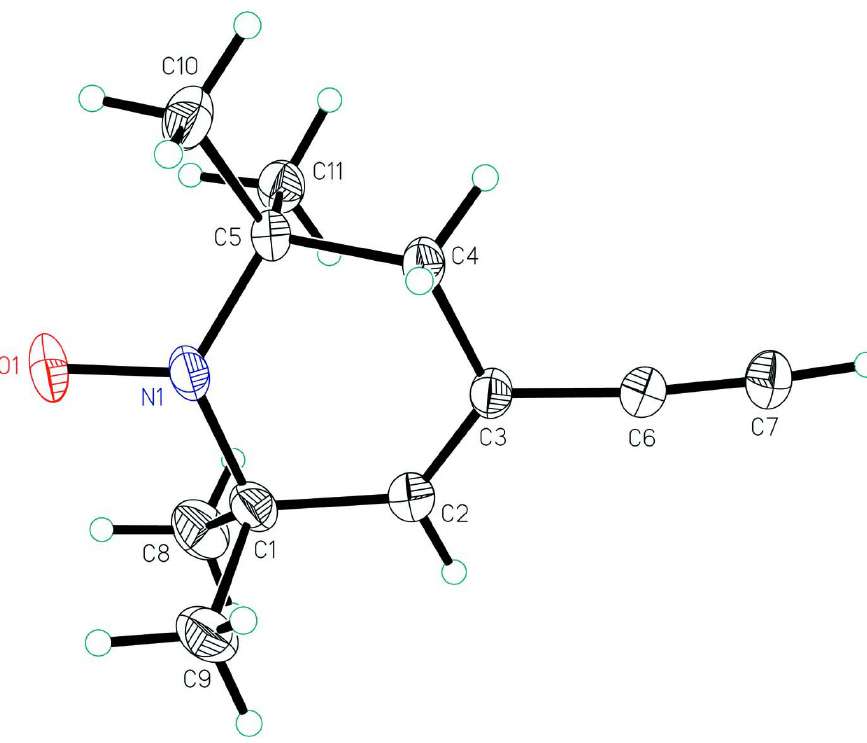
The molecular structure of the title compound, shown with 50% probability displacement ellipsoids. H atoms are drawn as small spheres of arbitrary